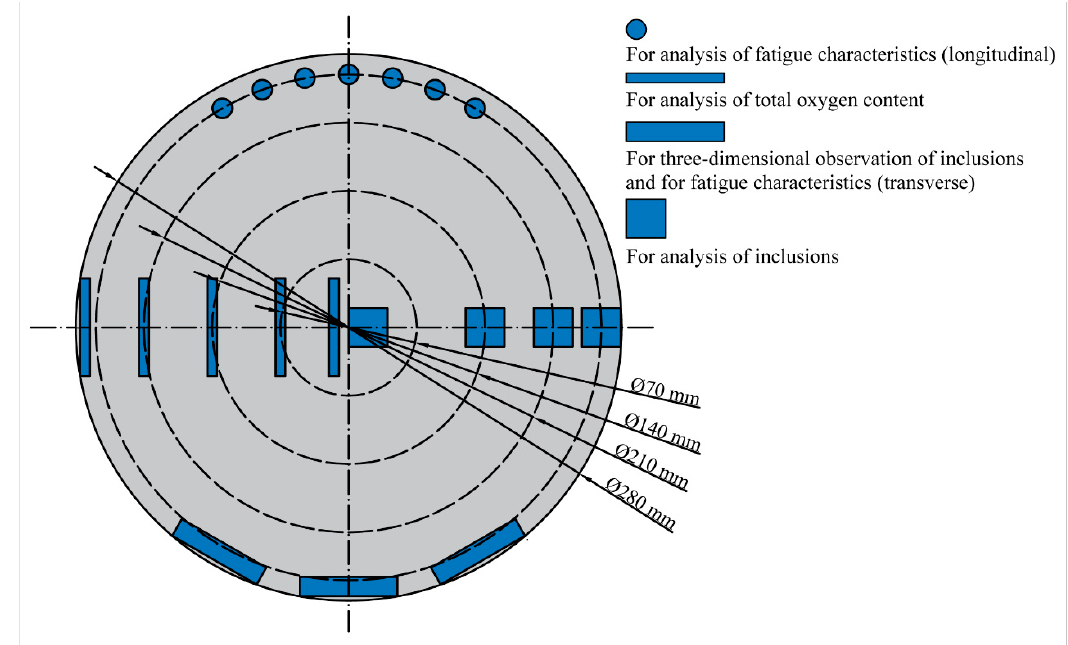
Figure 1. Sampling preparation of 18CrNiMo7-6 forge piece.